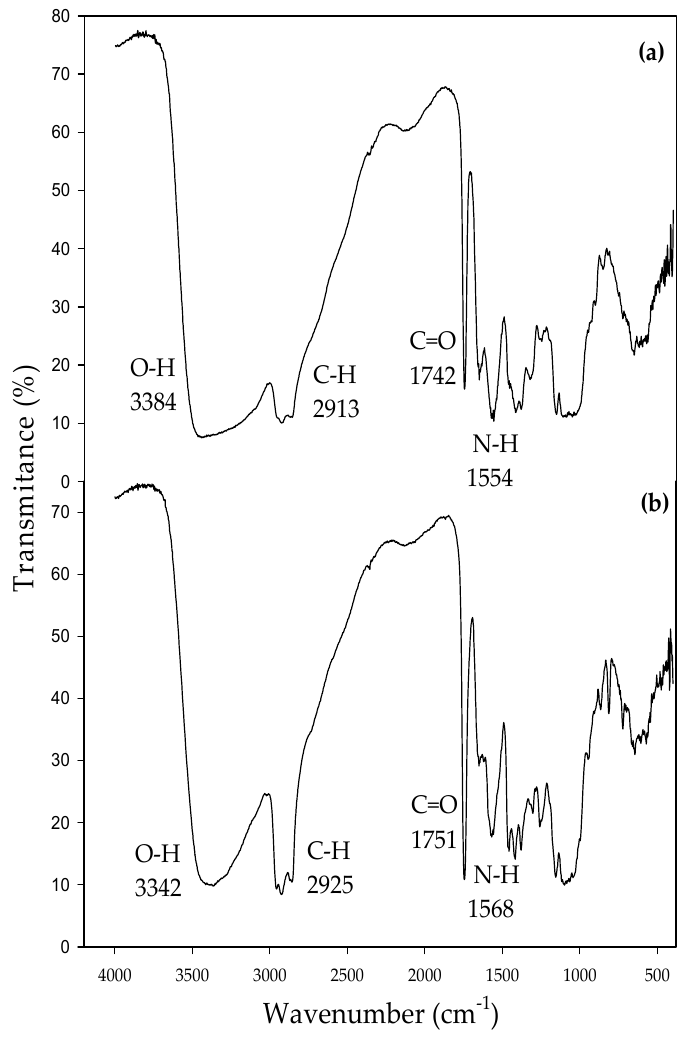
Figure 2. FTIR spectra of chitosan-wax ( a ) and chitosan-OEO-wax ( b ) films.